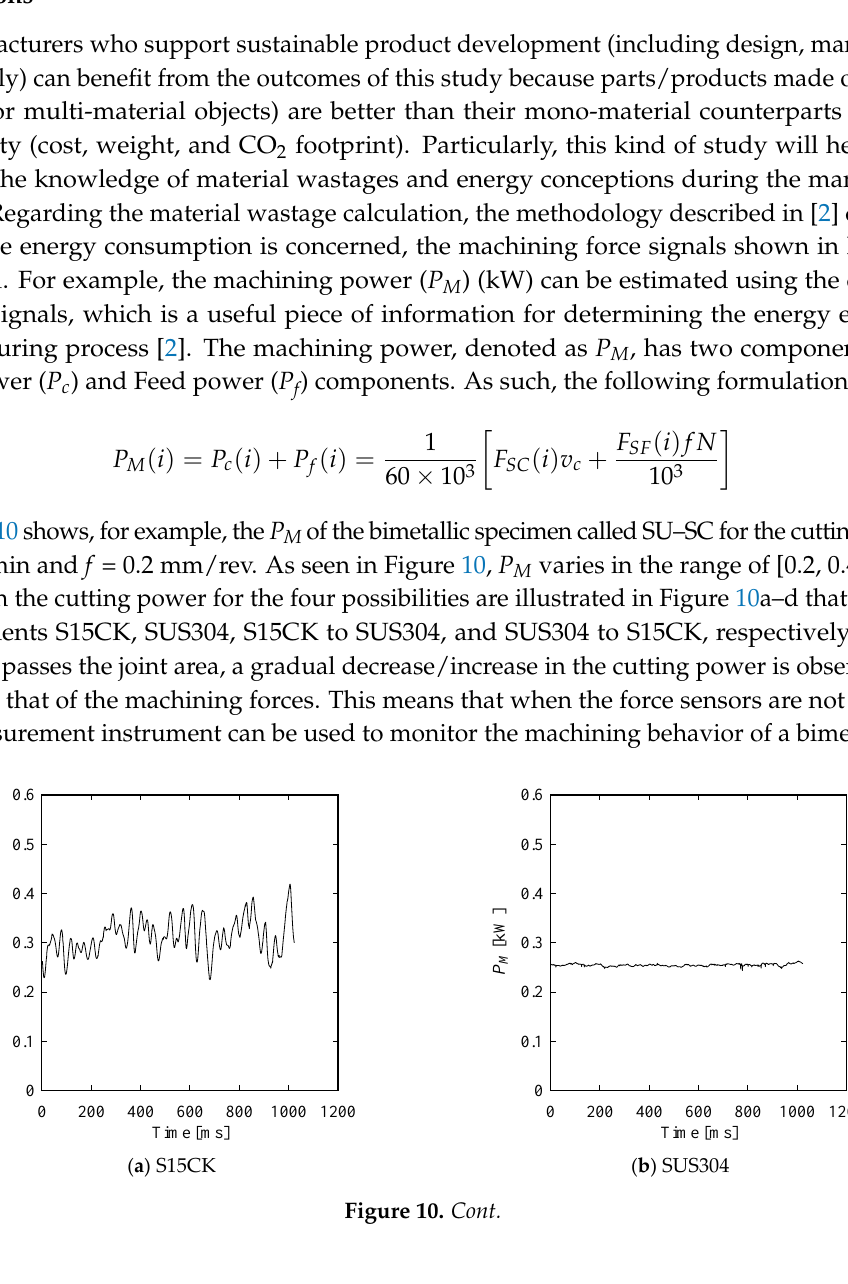
Figure 9. Uncertainties in the machining forces underlying Al–CI.